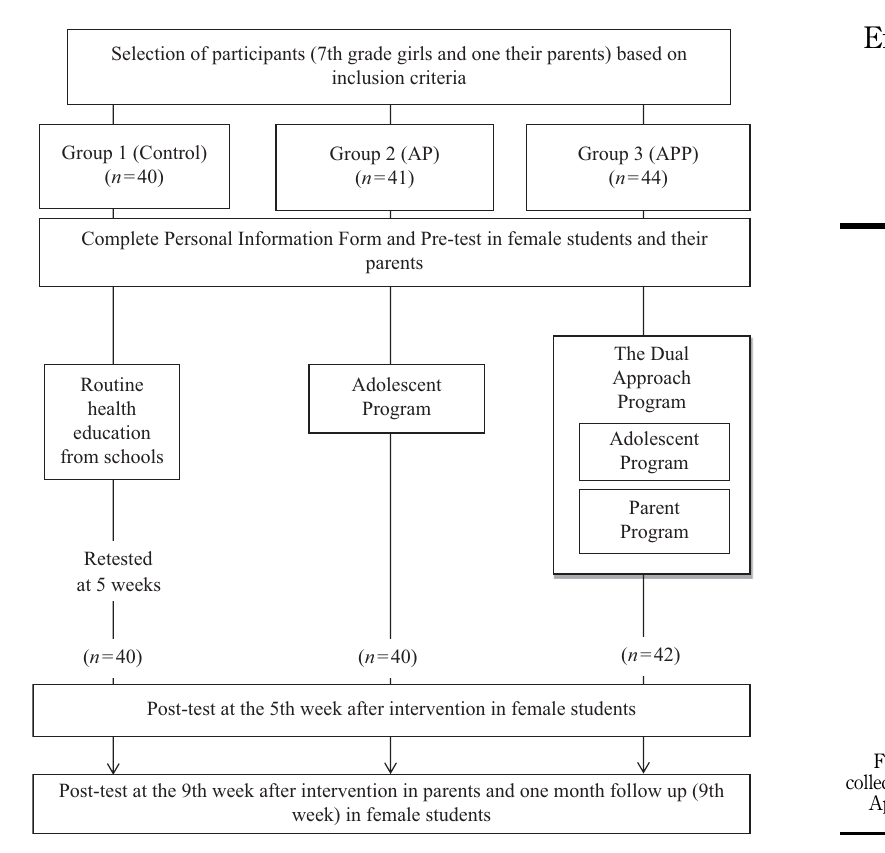
Figure 2. Flow chart of